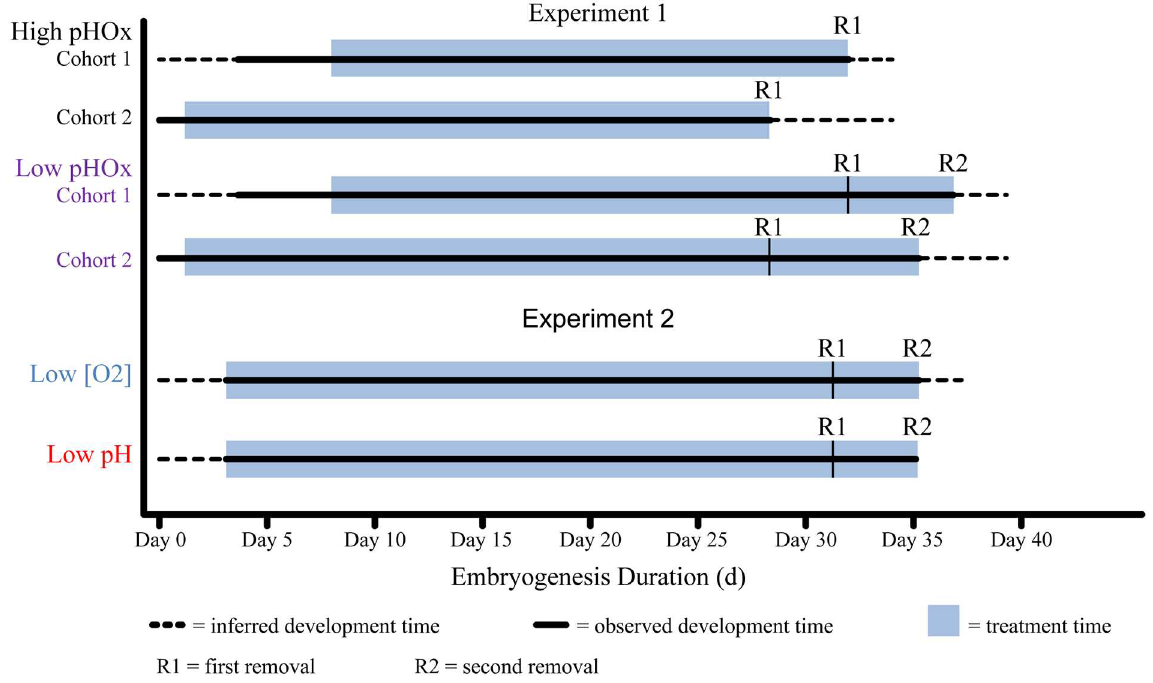
Fig 1. Exposure period for each treatment. D . opalescens capsuleexposureduration(blue box) for each treatment. R indicates when embryo capsuleswere removed. R1 = first removal. R2 = second removal. Note: embryos from the High pHOx treatment were all collectedat R1. Solid line = observeddevelopment time. Dotted line = inferred development time.